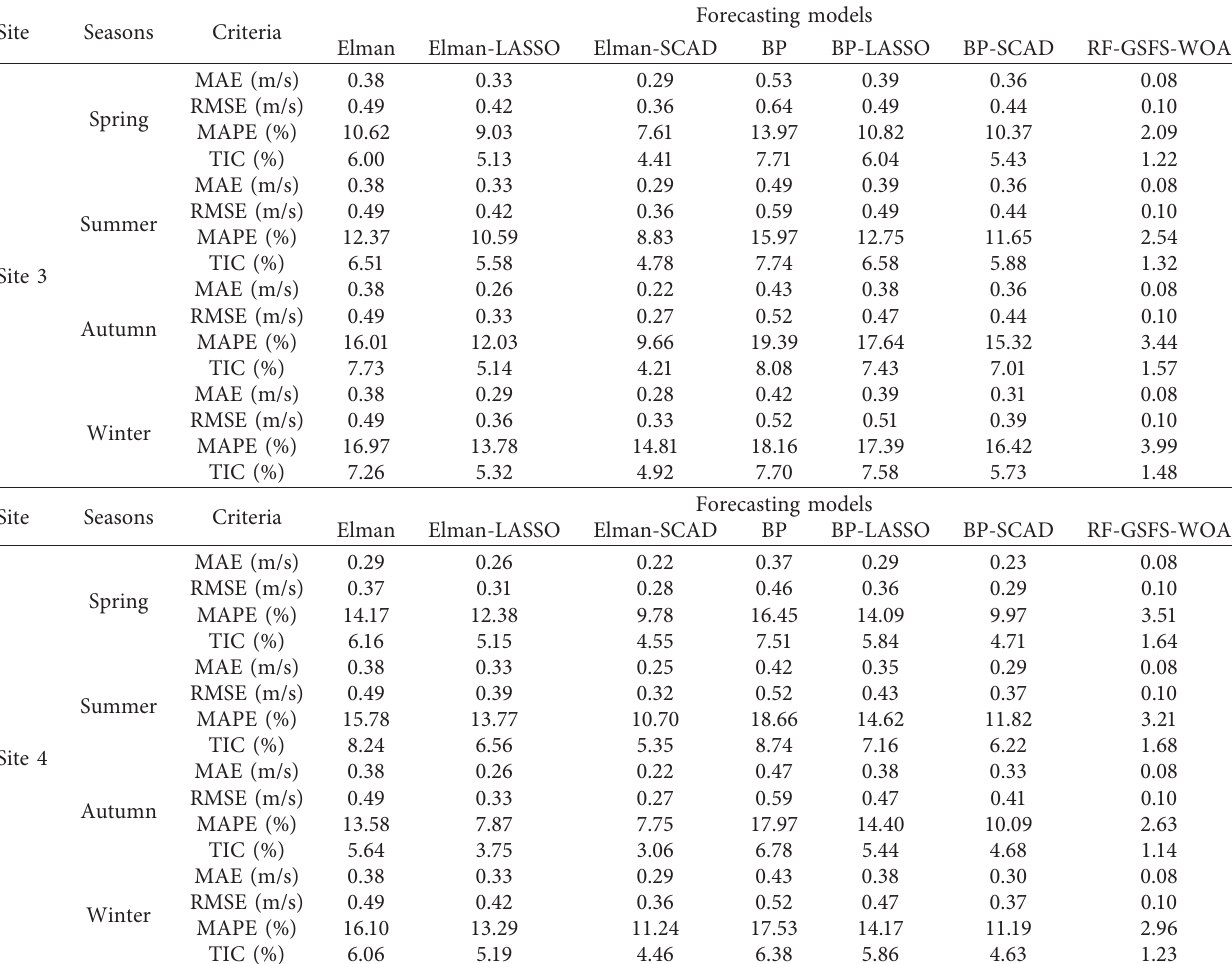
Table 4: Forecasting performances of the proposed model and other models in four seasons at Site 3 and Site 4. Site